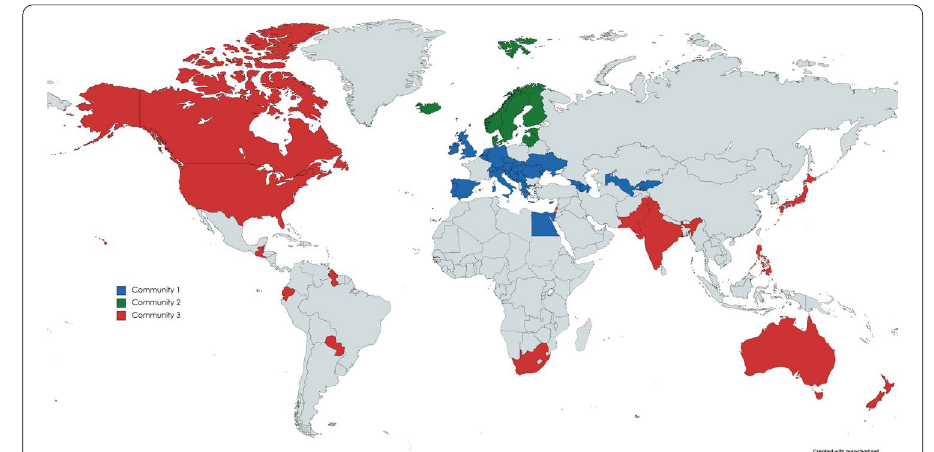
Fig. 10 World map with the communities obtained by applying the Louvain method in 2019